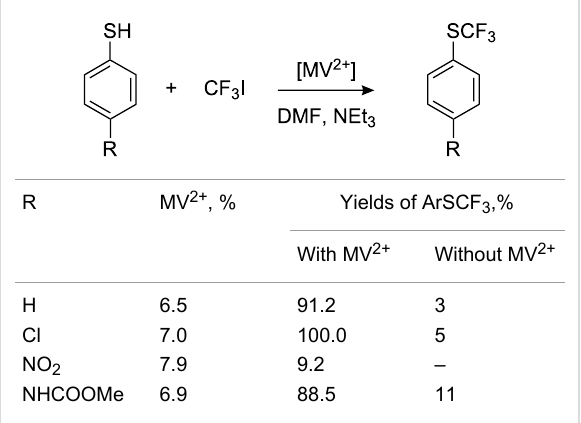
Table 10: Catalysis of trifluoromethylation by methylviologen